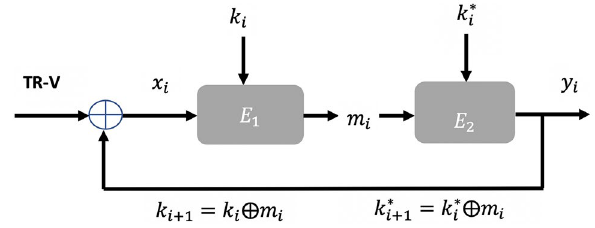
Figure 11. TRNG Cipher block.